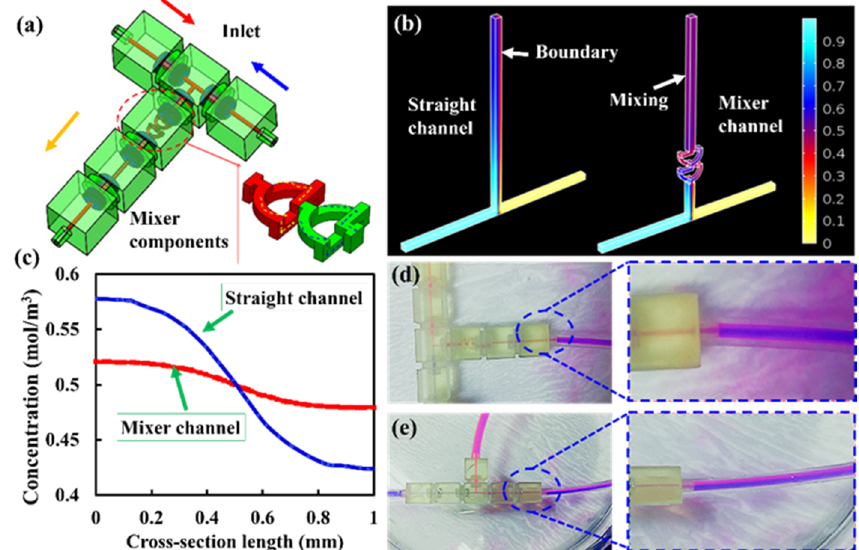
Figure 5. ( a ) schematic illustration of microfluidic system assembly with mixed channel module. ( b ) simulation of mixing effects for straight channel and mixer channel modules. ( c ) normalized concentration of the outlet for the straight channel and mixer channel modules, respectively (the terminal of the microchannel). ( d , e ) mixing effects of fluids in straight channel and mixer channel modules.